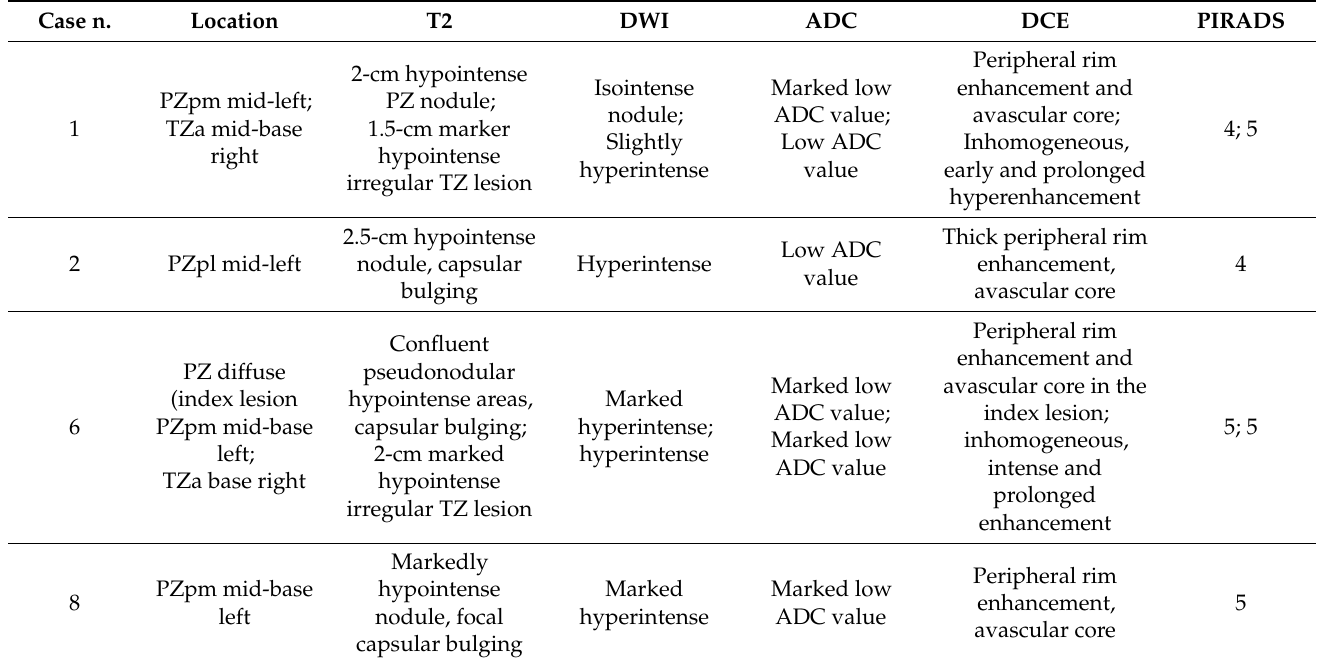
Table 2. mpMRI imaging features in BCG-GP patients.